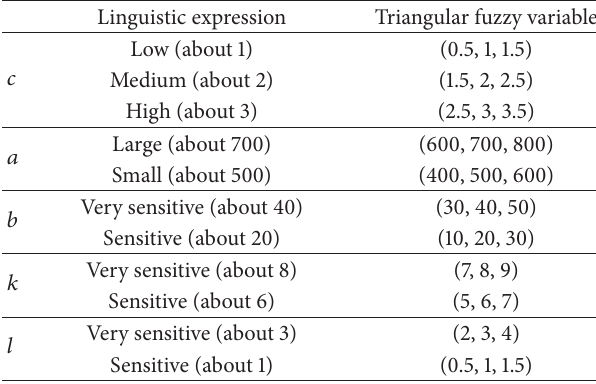
Table 1: Relationship between linguistic expression and triangular fuzzy variable.